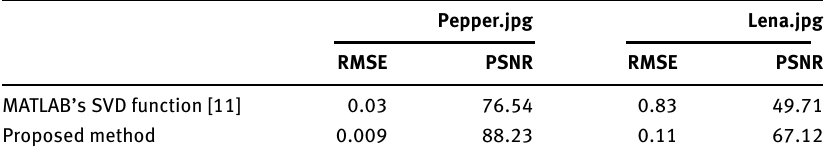
Table 1: Application to Other Images.